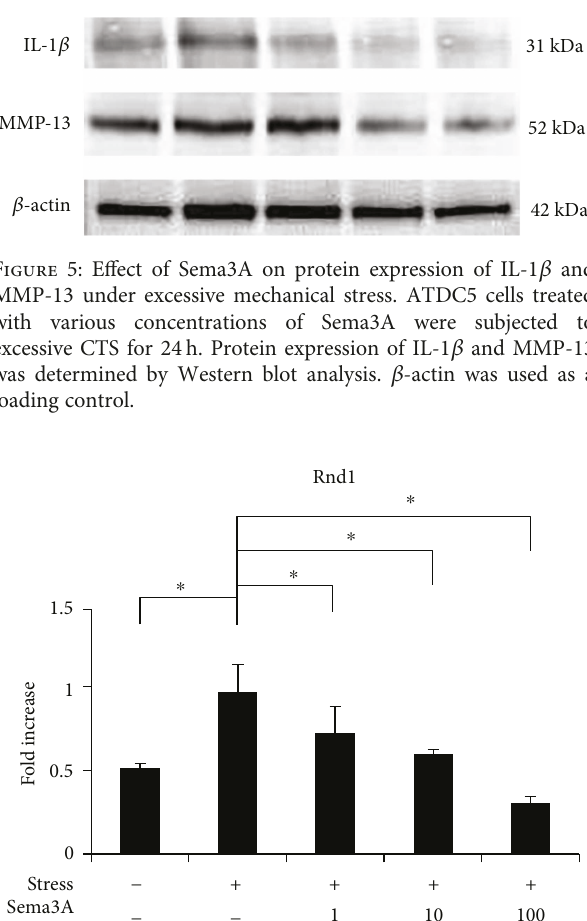
Figure S1: time course of marker gene expression during dif- ferentiation of ATDC5 cells. Cells were grown in 6-multiwell plates. Total RNA was isolated on the indicated day of culture and analyzed by real-time PCR analysis. Data are expressed as mean ± SD, n = 3 . ∗ P < 0 05 , ∗∗ P < 0 01 , compared to con- trols at each time point. Figure S2: FX-2000 Flexcell system.